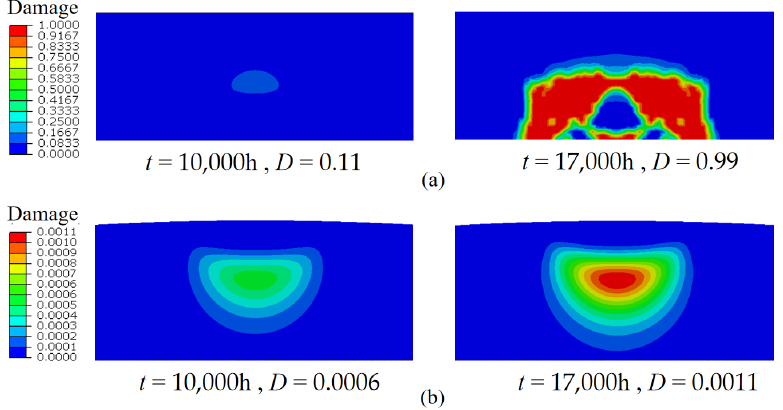
Figure 6. Damage nephogram of the main roller and raceway: ( a ) Roller ( b ) Raceway. Taking the simulation results of the main raceway as an example, the damage evolution over time is shown in Figure 7. From the perspective of spatial domain, the damage of the raceway starts from a subsurface position 0.6 mm from the raceway surface and extends to the surface along a horizontal angle of 45 ◦ , gradually forming fatigue spalling, which was consistent with the results in the literature [15], as shown in Figure 8. From the perspective of time domain, when the working time is less than 15,000 h, the damage evolution of the main push raceway is slow. When the working time reaches 15,000 h, the damaged area expands rapidly, and the maximum damage increases from 0.33 to 0.99 in only 1000 h. Therefore, it is recommended to set the critical damage as